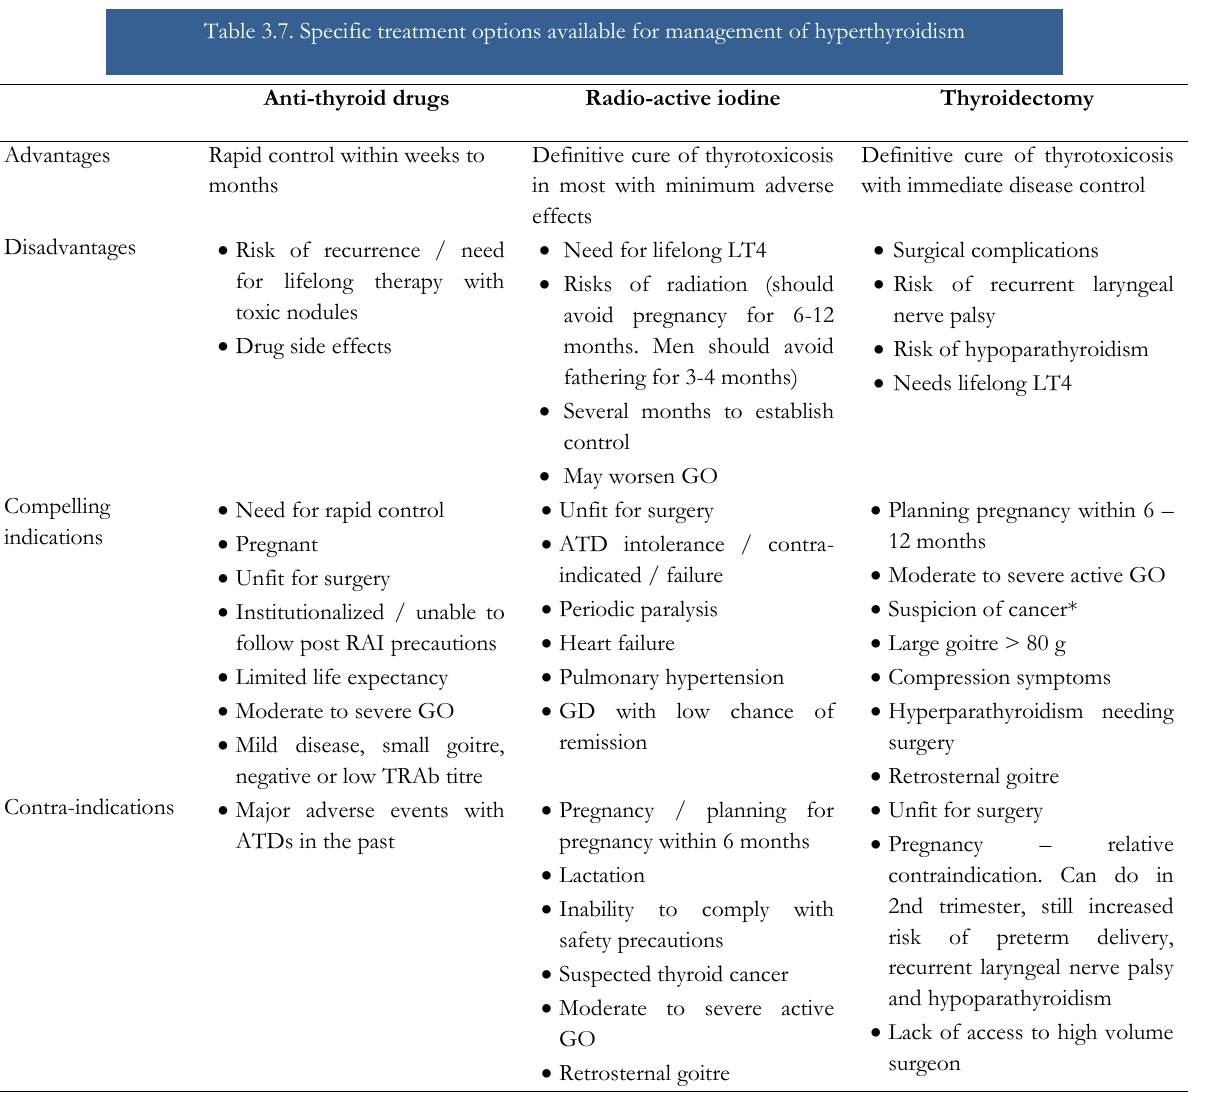
Table 3.7. Specific treatment options available for management of hyperthyroidism